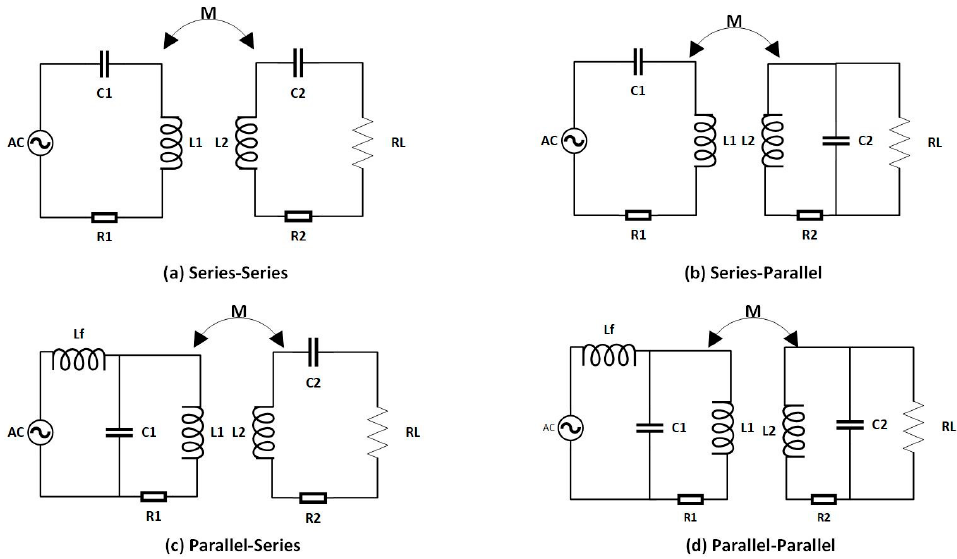
Figure 15. Different types of IPT compensators that: ( a ) (SS), ( b ) (SP), ( c ) (PS), and ( d ) (PP) reference.